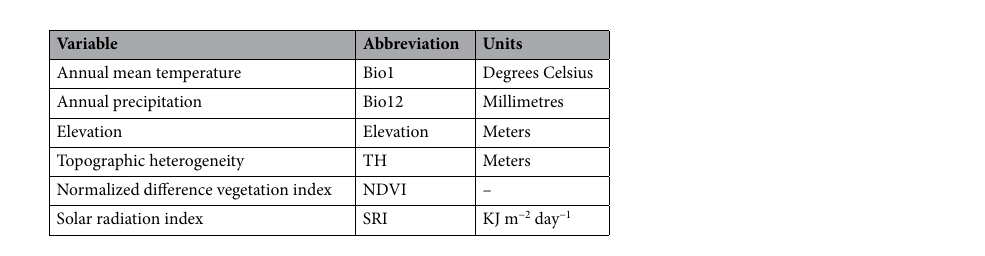
Table 2. The list of environmental variables used for modelling Eusparassus clades in the current study.